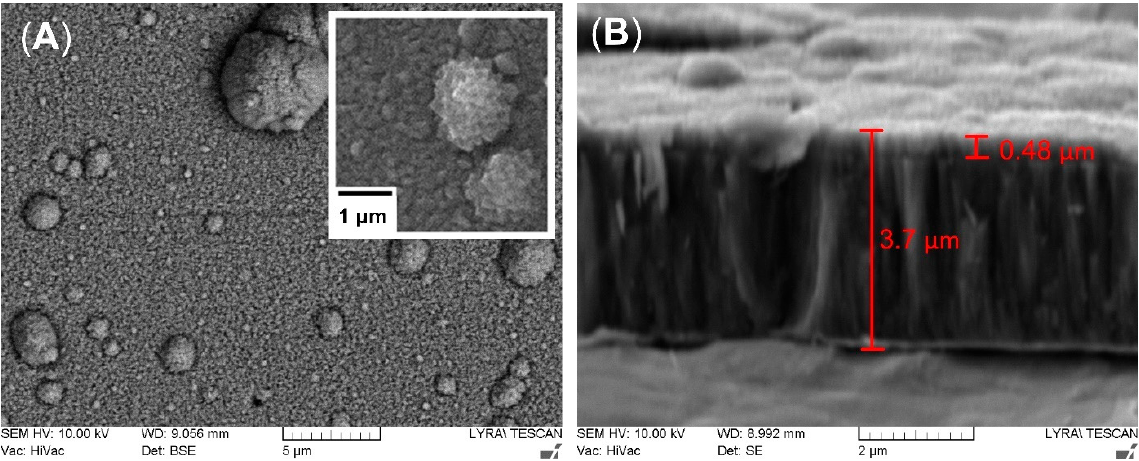
Figure 3. Representative SEM micrographs of the top view ( A ) and cross-section ( B ) of TiN/TiO 2 coating. Enlarged magnification reveals the surface morphology of the oxide crystals. The measurement of whole thickness of the coating includes the white-looking intermediate pure titanium layer below TiN sublayer.